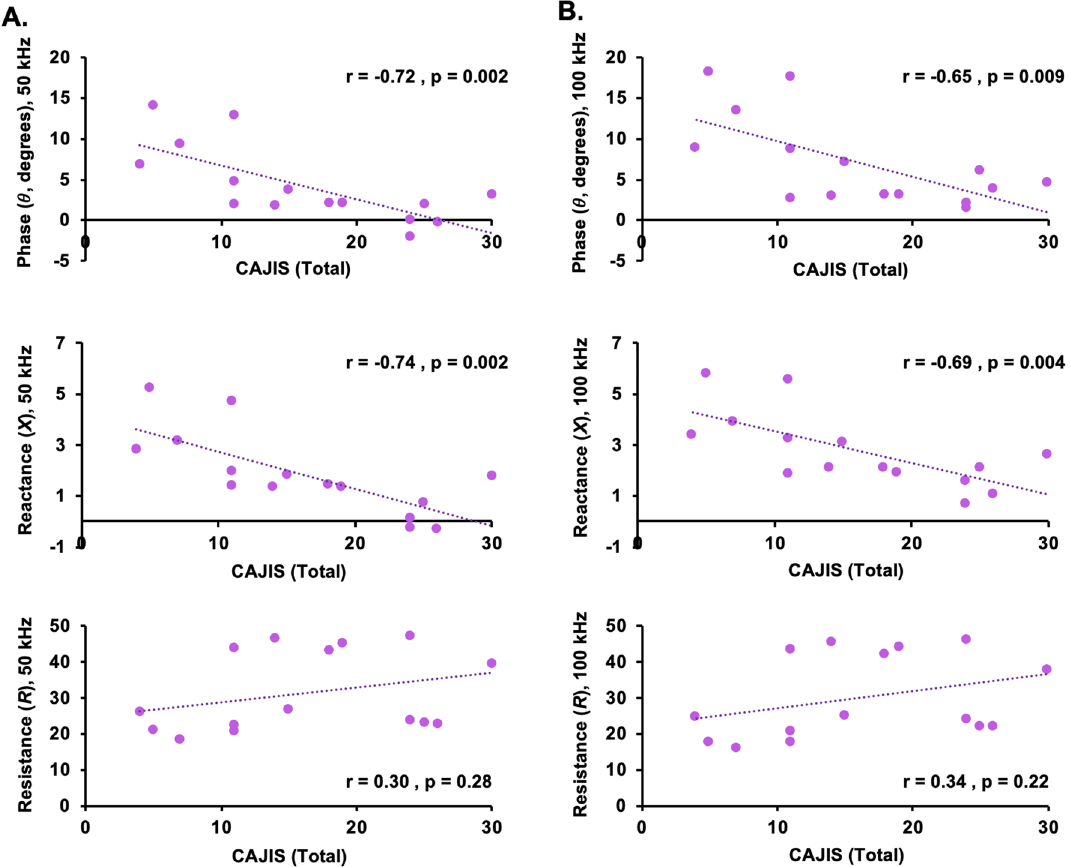
Figure 4. Association between total CAJIS scores and EIM measures ( θ , X , and R ). At 50 kHz ( A ) and 100 kHz ( B ), robust negative correlations between CAJIS scores and θ (top row) as well as CAJIS and X were observed. A non-significant positive correlation trend between CAJIS scores and R (bottom row) was present. Correlation results in general were comparable between 50 and 100 kHz. Pearson’s correlation analysis results and two-tailed p-values are reported. Whole-body or composite EIM measures were solely utilized in correlation analysis. Negative correlations identified for θ and X combined with group-level comparisons shown in Fig. 3 indicate more diseased muscle tissue in patients with